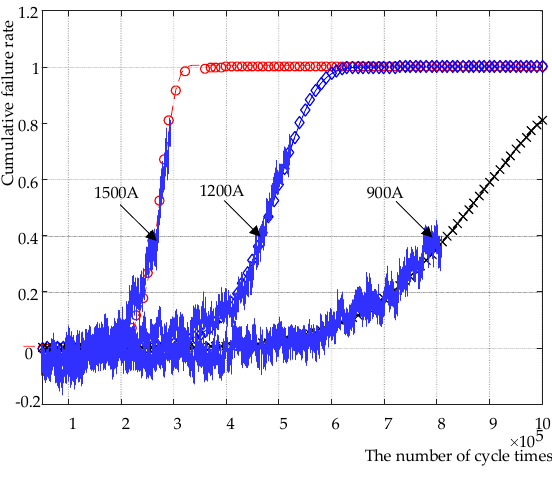
The number of cycle times Curve Fitted by Weighted LSM C u m u l a t i v e f a il u r e r a t e Curve Fitted by Genetic Algorithms Figure 14. Comparison of Weibull distribution fitted by GA and curves fitted by weighted LSM (least squares method). According to Figure 14, the curve of the function that was obtained by GA and curve 2 almost coincides in the interval of cycle number [4 × 10 5 , 8 × 10 5 ], which proves that the weighted LSM can more accurately fit the distribution function. Compared with the GA, the computational complexity of weighted LSM is greatly reduced and the computation time is shortened by 27% compared with the GA. So, the weighted LSM is more suitable for fitting the distribution.